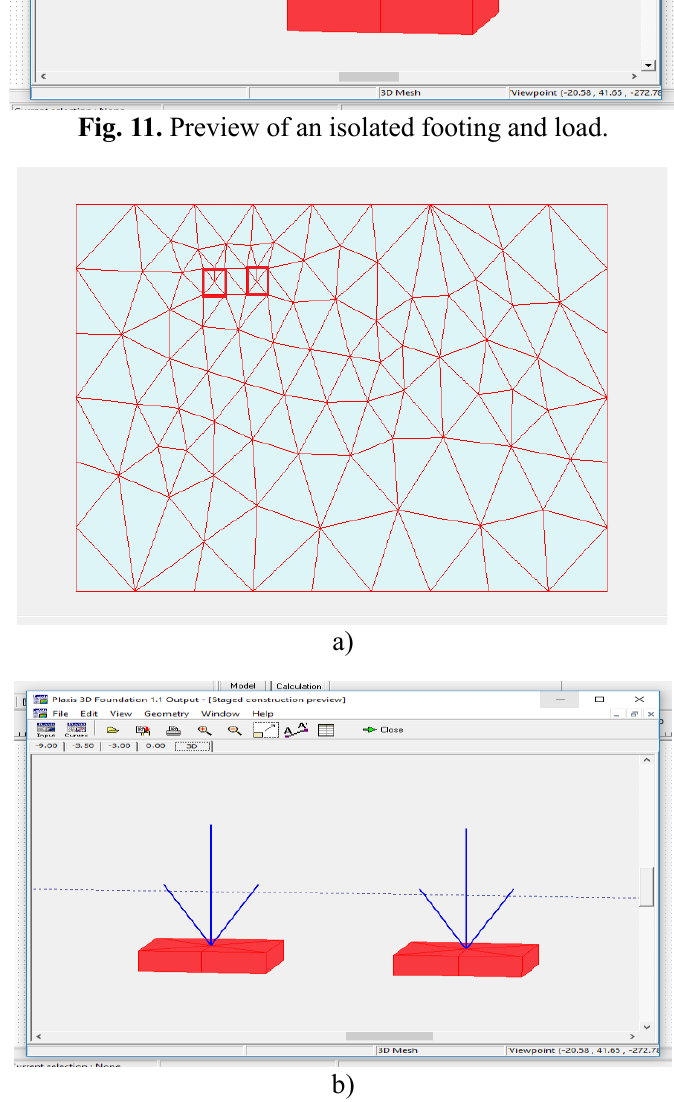
Fig. 12. Preview of two adjacent footing. a) 2D mesh of two footing, b) Preview of two adjacent footing and